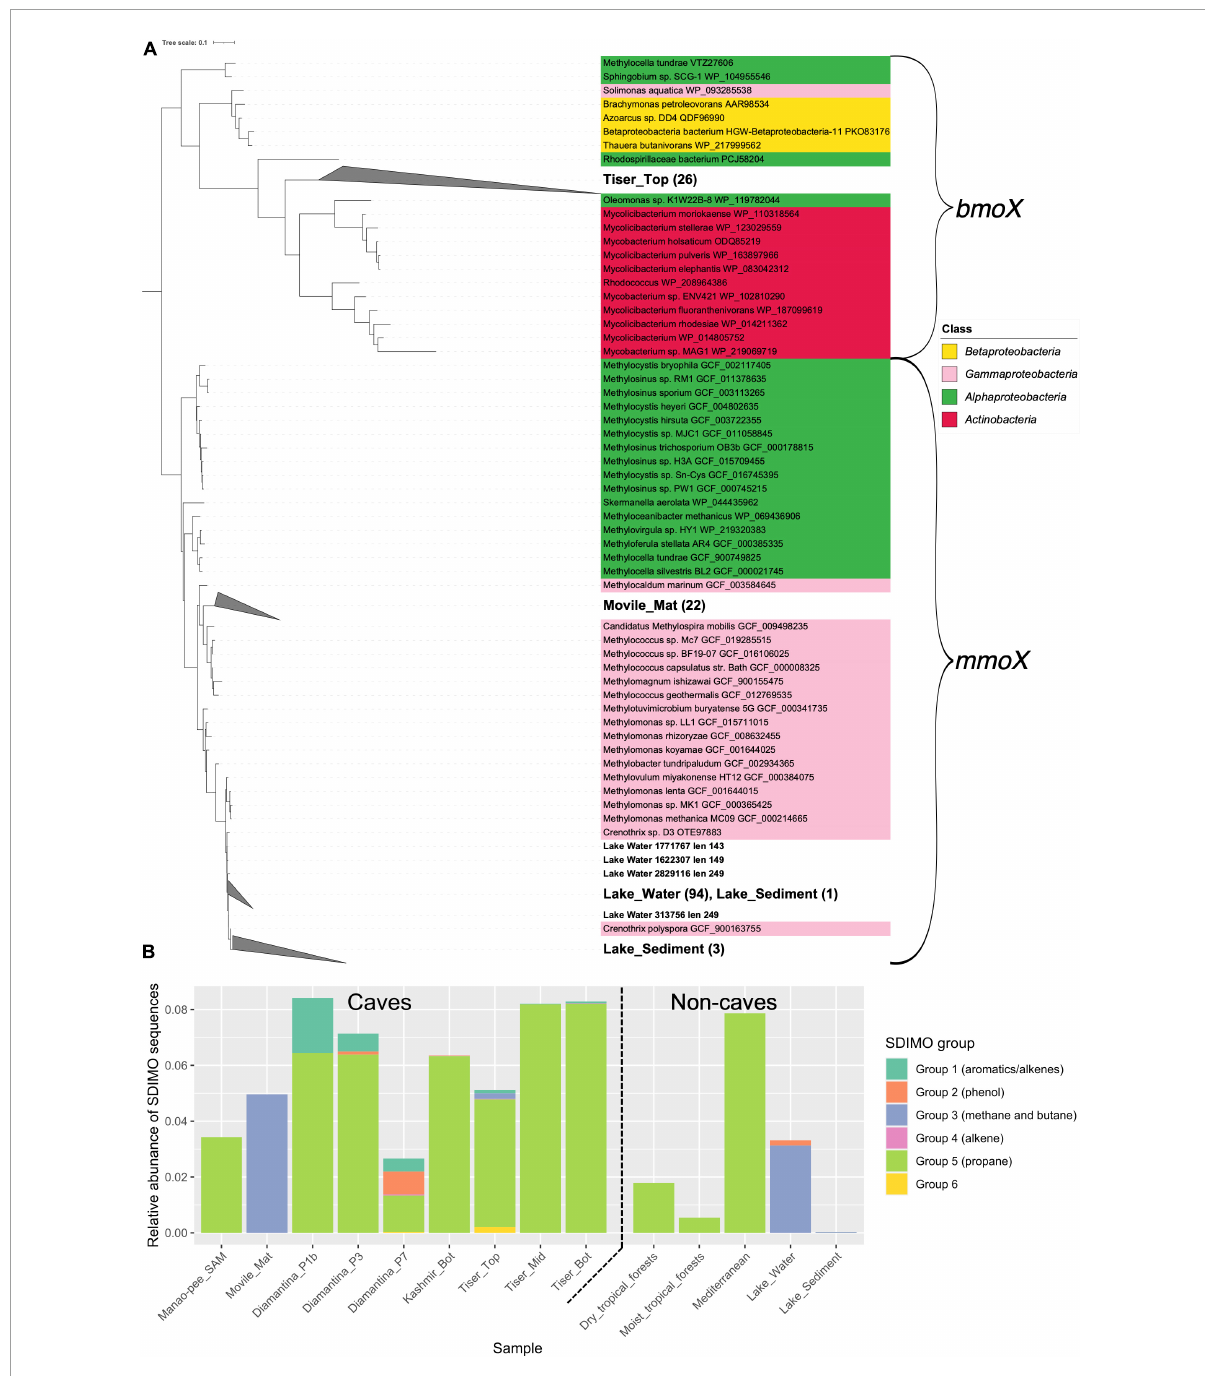
FIGURE4 A maximum-likelihood phylogenetic tree of group 3 soluble di-iron monooxygenases (SDIMOs) sequences retrieved from cave metagenomes (A) relative abundance of SDIMO groups (B) retrieved from cave metagenomes. Protein sequences from the metagenome samples were assembled by PLASS and concatenated to form a single cave protein catalog which was searched using HMMER3. Hit sequences were aligned to protein reference sequences using Clustal Omega. Conserved regions in these alignments were identified using trimAl. Phylogenetic reconstruction of alignments was conducted using IQTree. (A) Sequences classified as belonging to SDIMO group 3 are shown. Sample metagenome sequence labels are bolded. Clades with more than 3 and sequences consisting only of sample metagenome sequences were collapsed, the number of sequences contained in these clades are shown in brackets. Reference sequences are colored according to their assigned NCBI taxonomy. (B) Cave SDIMO sequences were classified into the groups described in Coleman et al. (2006) where they were broadly classified into physiological roles. The number of SDIMOs retrieved from each metagenome was normalized against the mean number of hits the single copy marker genes gyrB , recB , and rpoB . The tree used to classify cave SDIMO sequences can be found in Supplementary Figure 1